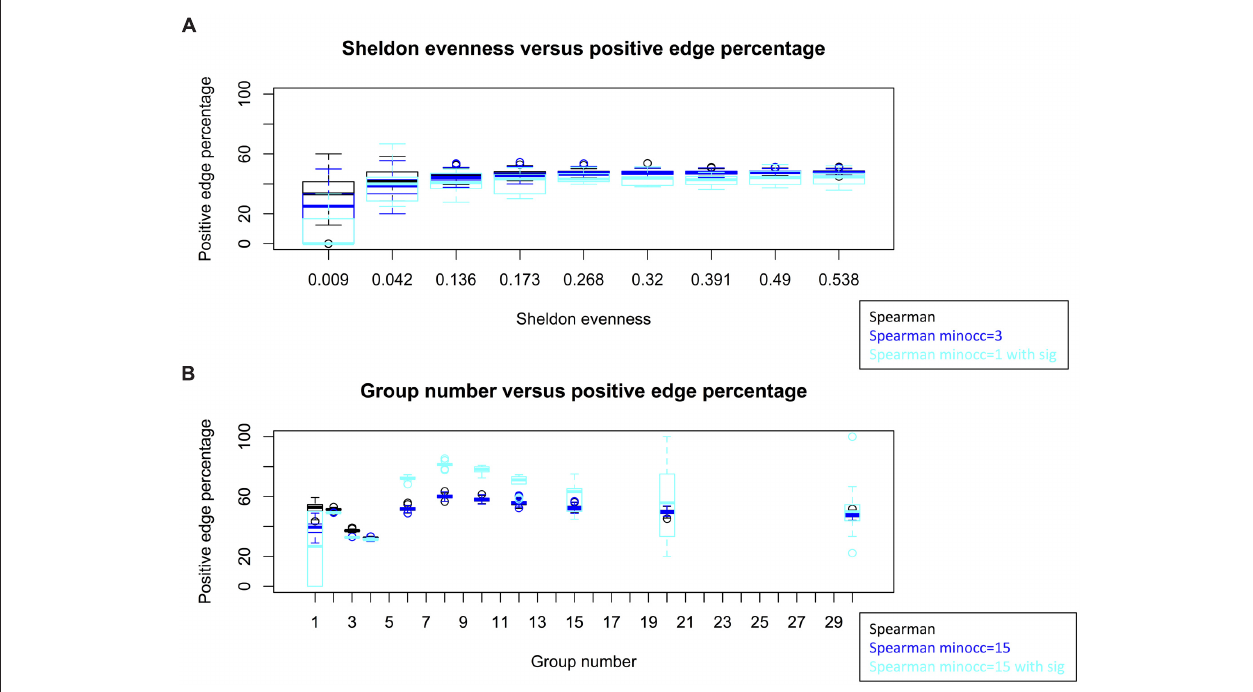
FIGURE 5 | Simulations with an interaction-free null model. Evenness does not alter PEP in simulations, though the variance of PEP increases for low evenness, when most taxa are absent across all samples (A) . When introducing group structure, PEP varies non-linearly with group number (B) . Count matrices were simulated with 50 taxa and 10 samples (A) and 120 taxa and 60 samples (B) and networks were built using Spearman with cut-off at ± 0.2. For the cyan box plots, significance was assessed by computing p -values from permutation and bootstrap distributions and correcting for multiple testing with Benjamini and Hochberg’s (1995) procedure. Matrix generation and network construction were repeated 100 times for each box plot (10 times when significance was assessed). Permutations and bootstraps were carried out with 100 iterations each. The parameter “minocc” refers to a filter step that removes all taxa occurring in less than the specified sample